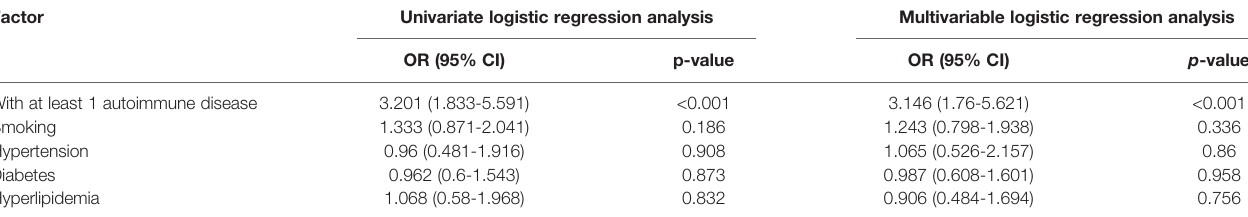
TABLE 4 | Conditional multivariable logistic regression analysis in SCCAD patients with IMH. Factor